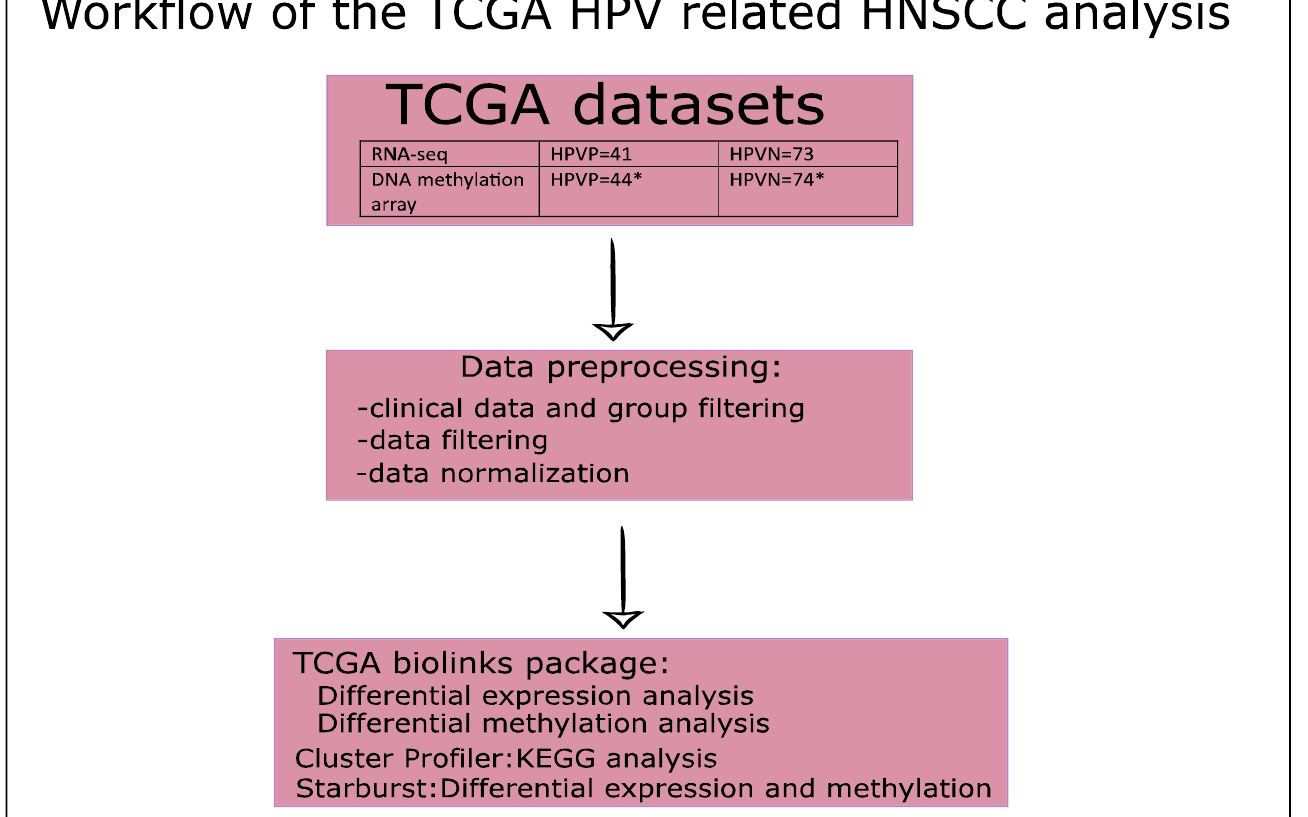
Figure 5. Workflow of the TCGA HPV-related HNSCC data. A schematic representation of the stepwise workflow of TCGA data analysis. * Clinical data analysis was performed only on RNA-seq patients’ data, and not on DNA methylation data.